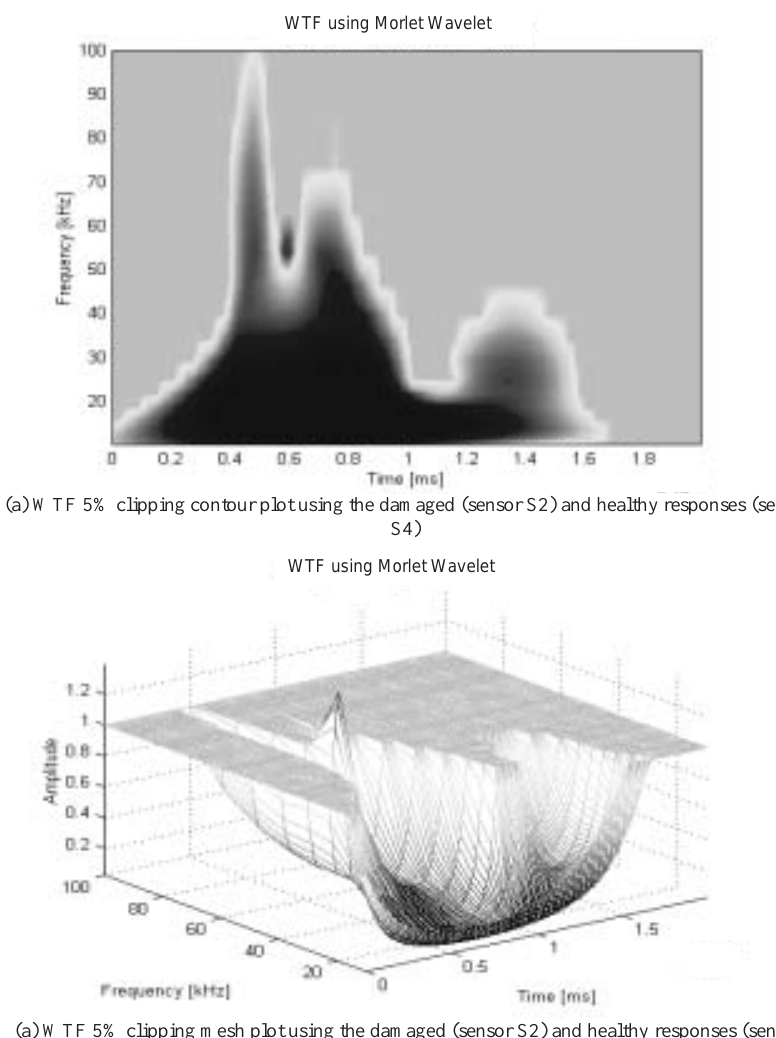
Fig. 22. WTF plots for the damaged helicopter